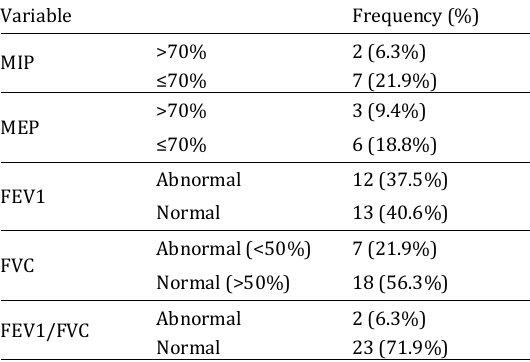
Table 2. Results of pulmonary function test in the study population Variable